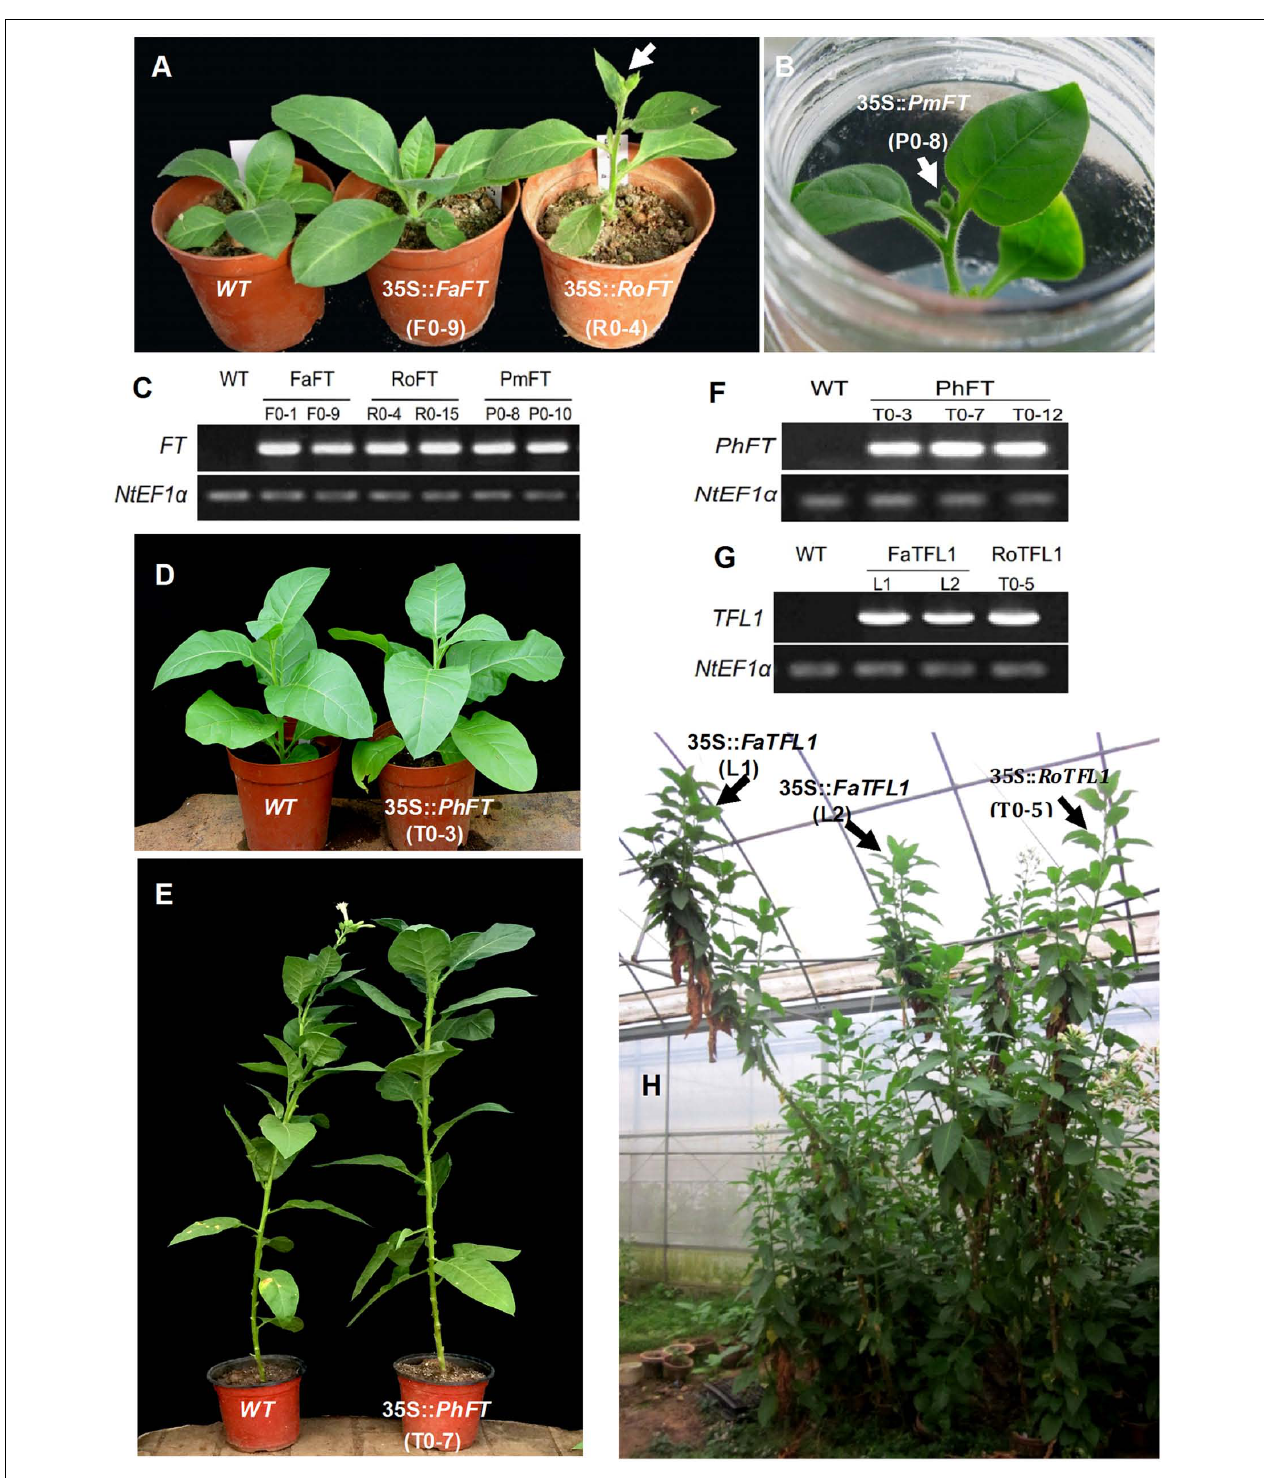
FIGURE 2 | Phenotypic analysis of transgenic tobacco plants harboring different FT/TFL1 homologs from various species. (A) From left to right are wild-type, and transgenic plants harboring FaFT and RoFT , respectively, after growth for 1 month. (B) Tobacco plant harboring 35S::PmFT and showing visible flower bud in culture box. (C) RT-PCR analysis to confirm the FT transgenic lines. (D,E) Transgenic tobacco plants harboring PhFT showing normal growth and no early flowering phenotype after growth for 1.5 and 5 months, respectively. (F) RT-PCR analysis to confirm PhFT transgenic lines. (G) RT-PCR analysis to confirm FaTFL1 and RoTFL1 transgenic lines. (H) Transgenic tobacco plants harboring FaTFL1 and RoTFL1 after growth for 13 months.